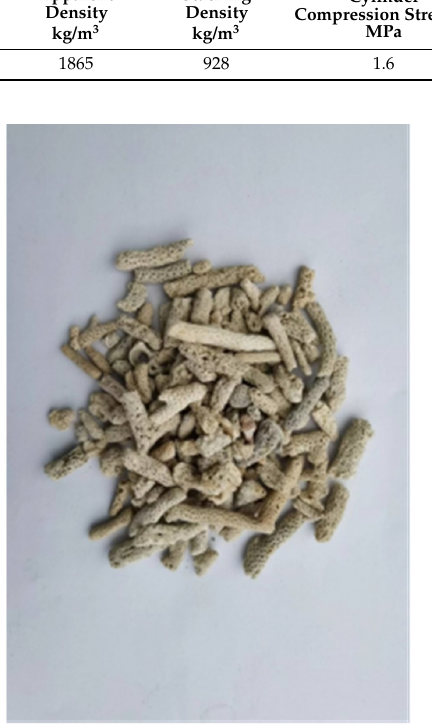
Figure 2. Coarse aggregate.